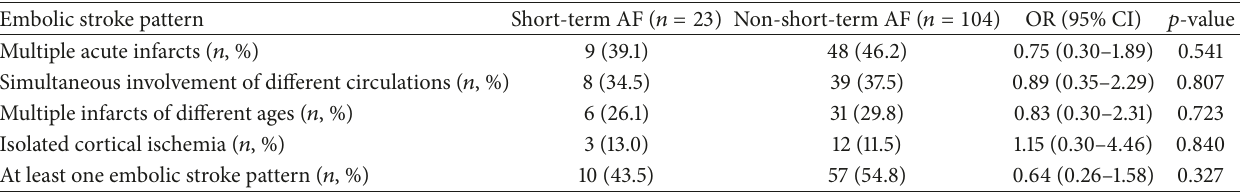
Table 3: Association between embolic stroke patterns and the short-term diagnosis of atrial fibrillation (new atrial fibrillation on baseline ECG or in 7 d Holter) ( 𝑛 = 127 ).